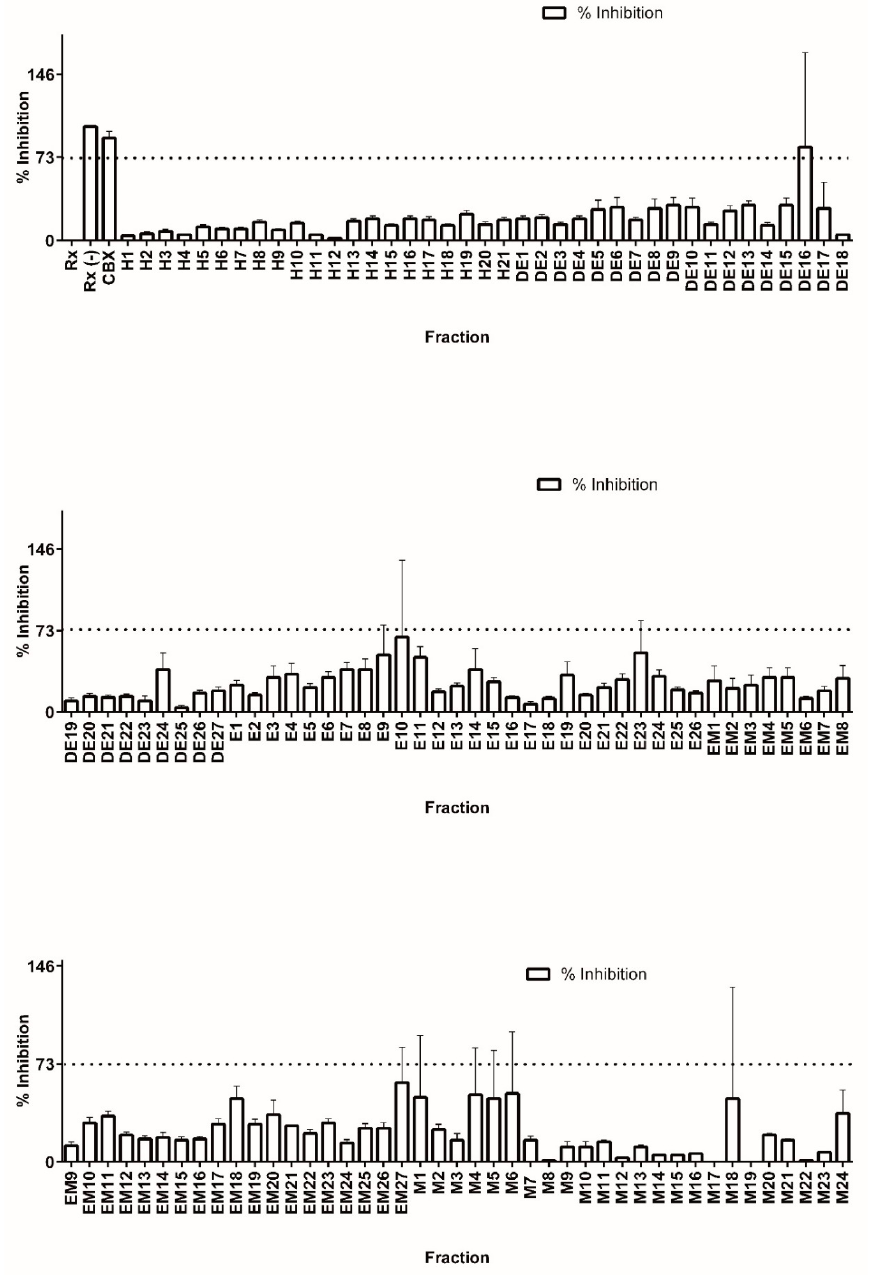
Figure 2. Screening of a C. telenitida library of plant root extracts for 11 β -HSD1 inhibitors. Percentage inhibition was calculated by comparing cortisol production in the presence and absence of 1 µg/mL of each fraction. Cortisol production was determined by HTRF. Fraction nomenclature is described in Table 1. Data represent mean ± S.D. from three independent replicates. Rx: Positive control, microsomal 11 β -HSD1 reaction. Rx( − ): Negative control, reaction assay minus NADPH. CBX: Positive control for inhibition, 11 β -HSD1 reaction with 0.9 µM carbenoxolone. The dashed line corresponds to the statistically significant inhibition cutoff.